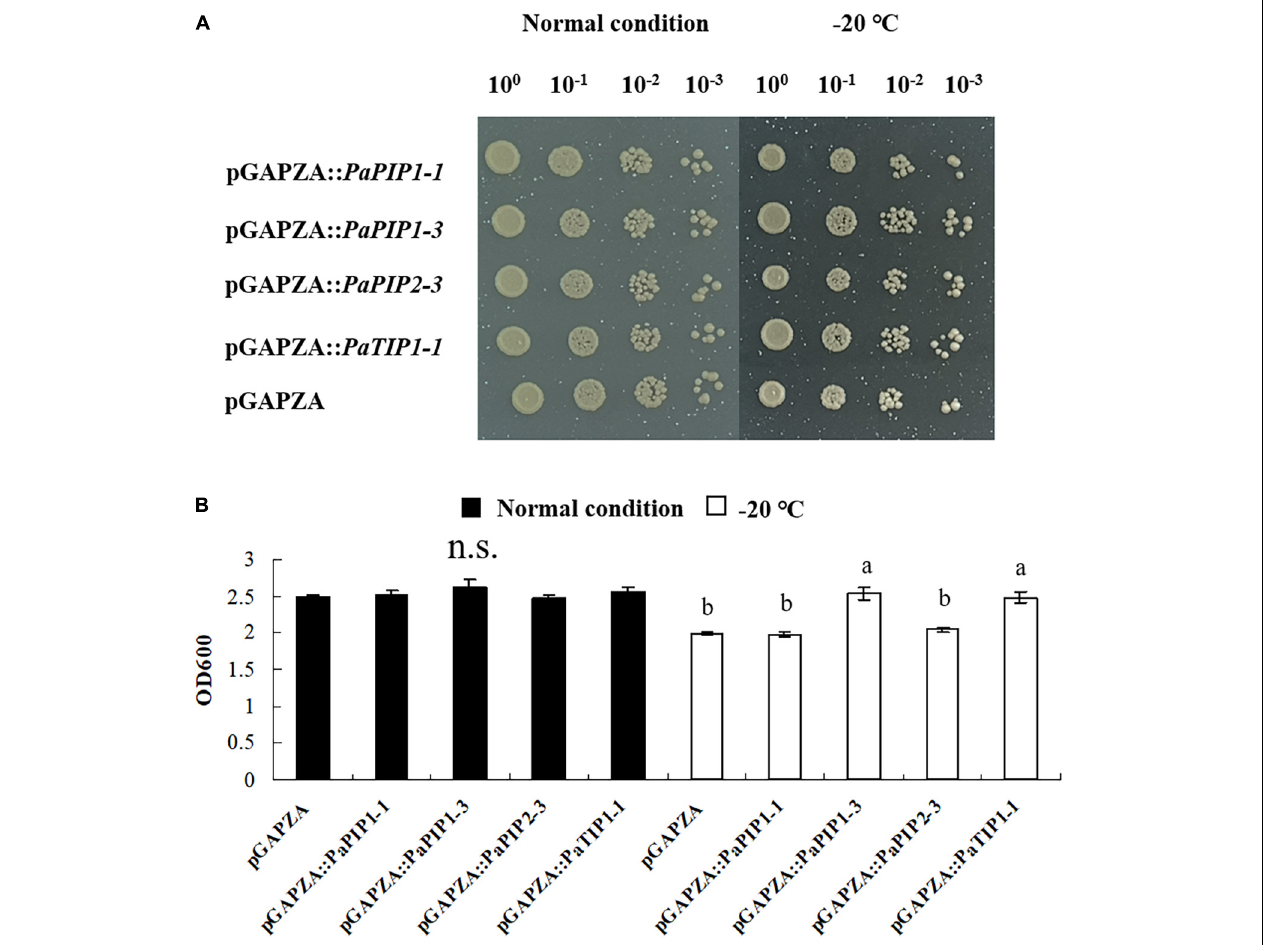
FIGURE 8 | Overexpression of PaPIP1-3 and PaTIP1-1 increases cold tolerance and accumulation in yeast. (A) Growth of the GS115 yeast strain transformed with the empty vector pGAPZA or with pGAPZA harboring PaPIP1-1 , PaPIP1-3 , PaPIP2-3 , or PaTIP1-1 . (B) OD600 value of yeast transformants in response to low-temperature stress. The data are the means ± SDs of three replications. n.s. means not significant. The different lowercase letters indicate significant differences at P < 0.05 by